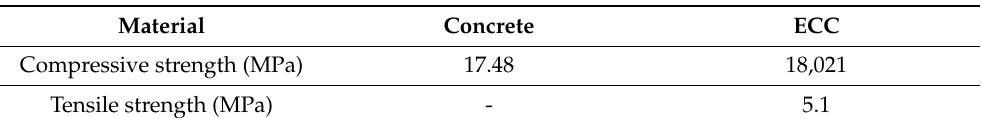
Table 5. Concrete